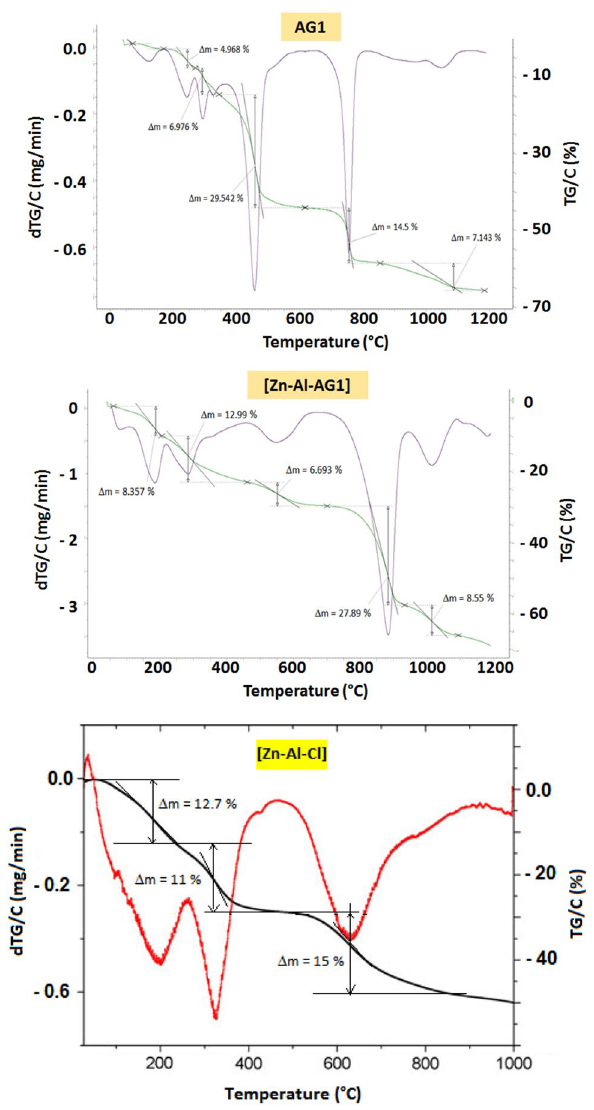
Fig. 10 TG and DTG curves obtained for pure AG1, [Zn–Al–AG1] and [Zn–Al–Cl]